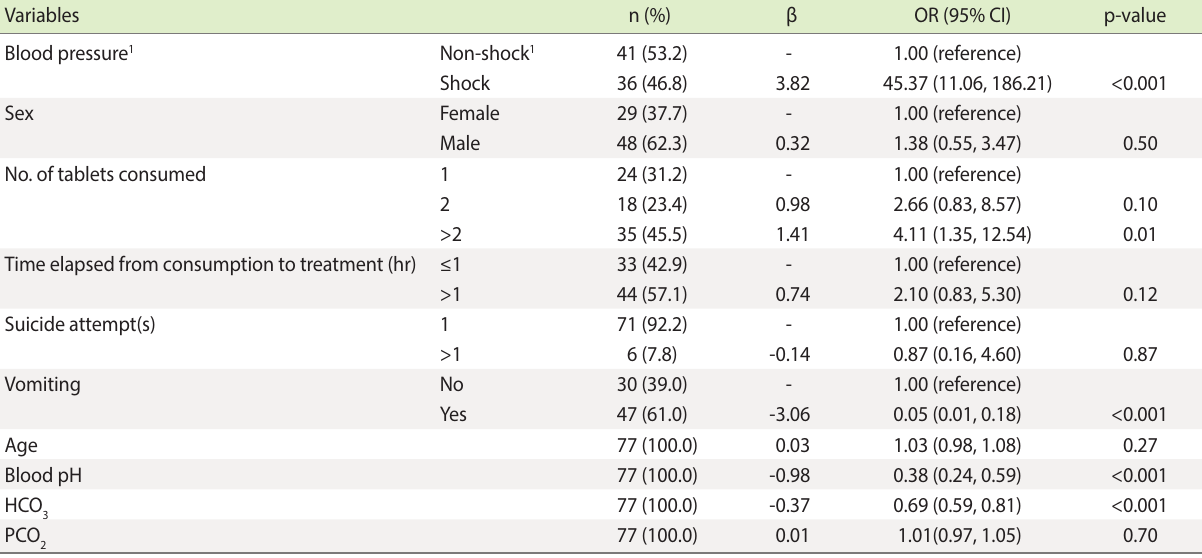
Table 2. Univariate logistic regression analysis for factors related to mortality from ALP poisoning in Kermanshah Province, 2014-2015 Variables